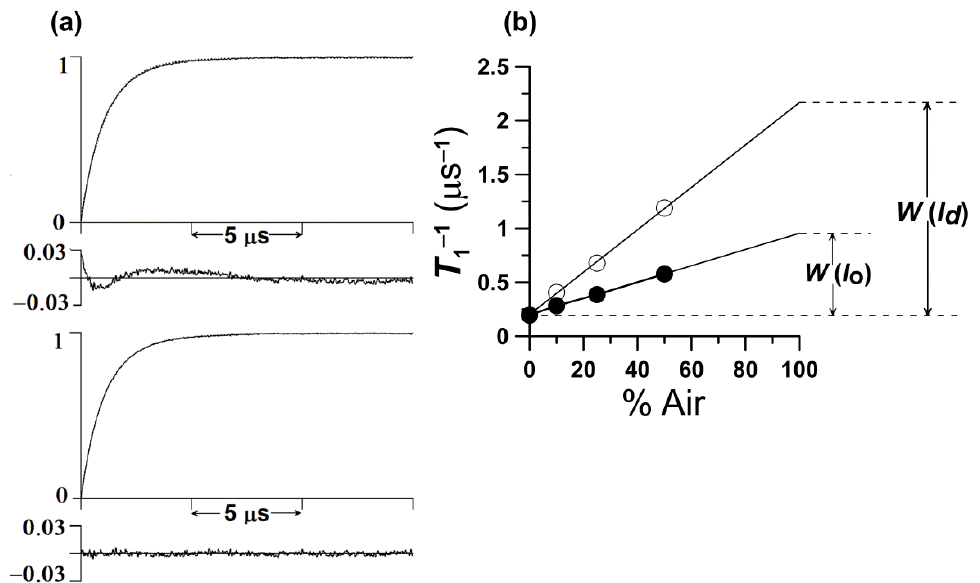
Figure 3. ( a ) Representative SR signal from 5-PC in the DMPC bilayer containing 20 mol% Chol obtained at 30 °C for the sample equilibrated with 50% air. In the deoxygenated sample, a single exponential signal is observed with a time constant of 5.10 µs (data not shown). In the presence of oxygen, fitting the search to a single exponential mode is unsatisfactory as shown by the residual (upper panel). The fit, using the double-exponential mode (time constants of 1.73 and 0.84 µs), is excellent (lower panel). The double-exponential fit is consistent with two immiscible domains (phases) with different OTPs that are present at these conditions. (We assigned them to the l d phase and l o phases). ( b ) Plot of T 1 − 1 for 5-PC in the l o and l d phases in a DMPC membrane containing 20 mol% Chol as a function of air fraction in the equilibrating gas mixture. Experimental points show a linear dependence up to 50% air, and extrapolation to 100% air is performed as a way of calculating OTPs in the l o and l d phases.